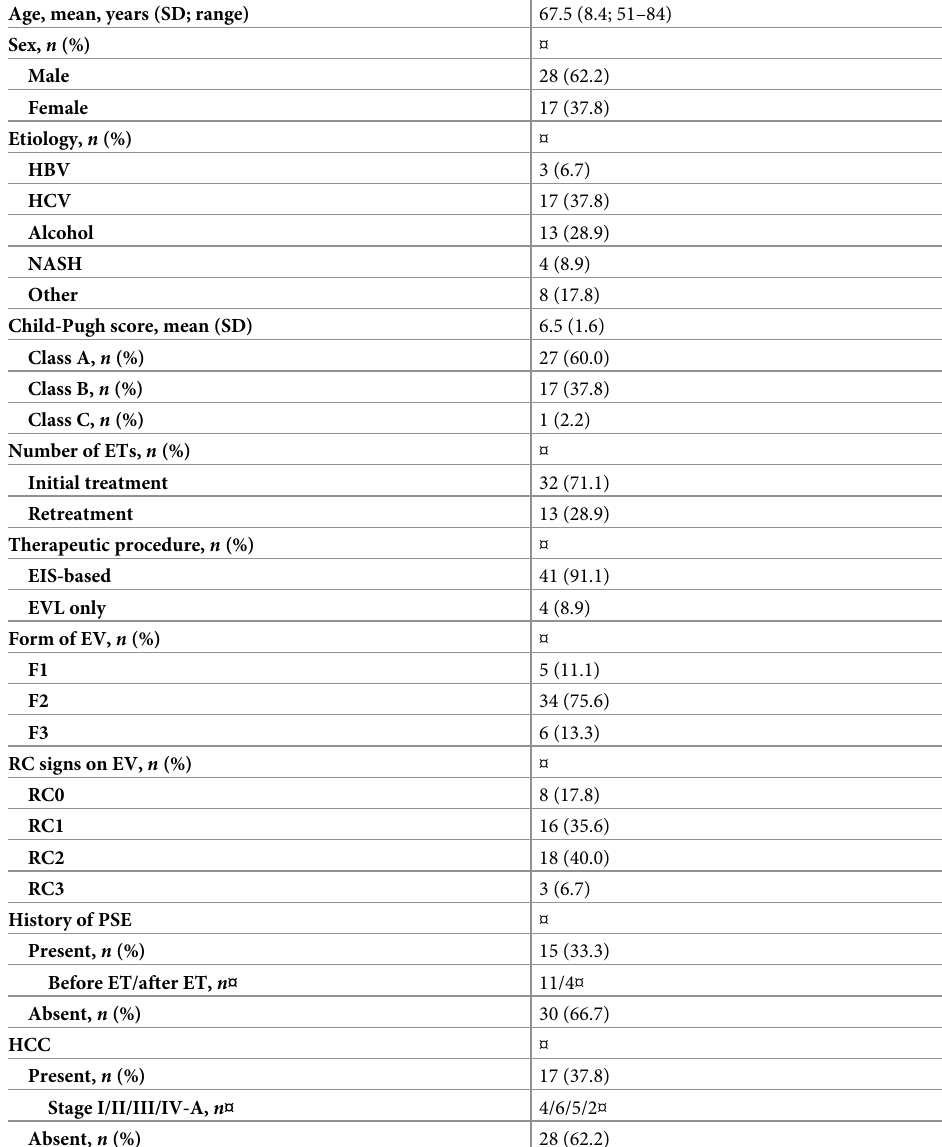
Table 1. Patients’ baseline clinical characteristics ( n =